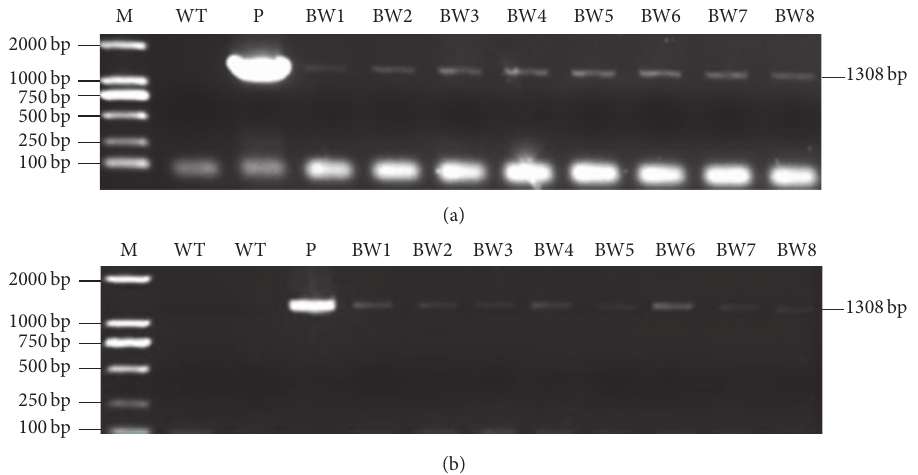
Figure 2: PCR and RT-PCR analyses of transformed and WT plants using BcWRKY1 primers. (a) PCR analysis of WL-73 and WT; M, DNA marker DL2000 (TaKaRa); WT, wild-type plants of LH1037; P, pCAMBIA3300- Ubi-WRKY1 plasmid; BW1-8 derived from plants of WL-73. (b) RT-PCR analysis of WL-73 and WT1; M, DNA marker DL2000 (TaKaRa); WT, wild-type plants of LH1037; P, pCAMBIA3300- Ubi-WRKY1 plasmid; BW1-8 derived from WL-73 plants.